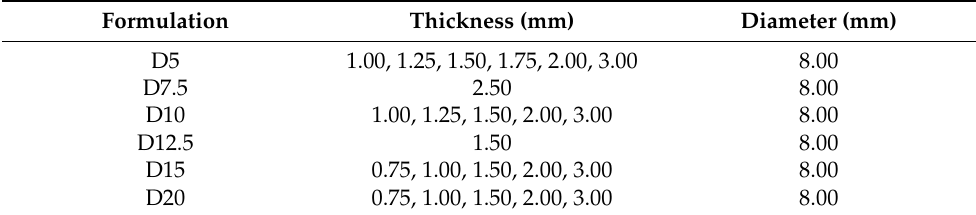
Table 4. Dimensions (diameter and thickness) of created 3D